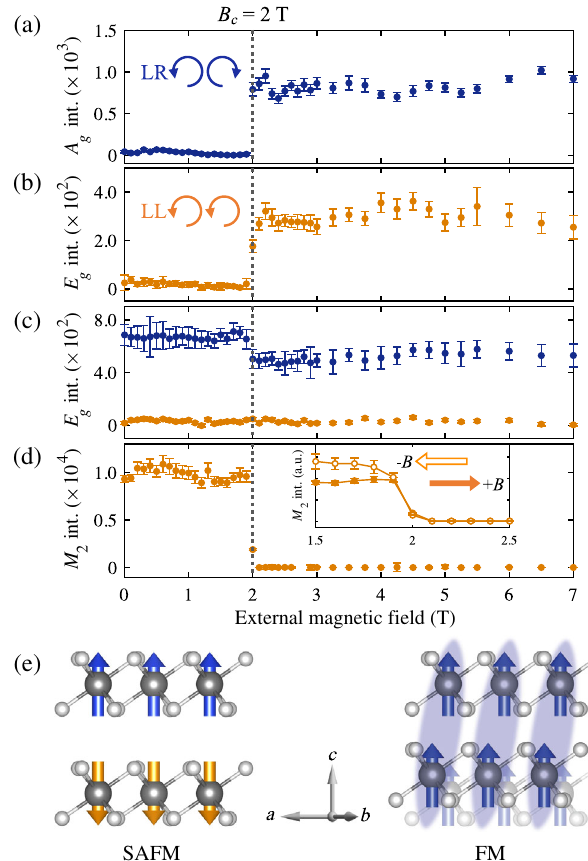
FIG. 3. Revealing the rhombohedral-to-monoclinic structural phase transition at B in 3D CrI 3 . Magnetic field dependence of c phonon (at approximately 129 cm − 1 ) (a) a representative A g intensity leakage into the LR channel, (b) an example of an E g phonon (at approximately 109 cm − 1 ) intensity showing up in the LL channel, which corresponds to the E phonon of the C 3 g i ð C Þ ] transforming into the A structure [i.e., E phonon of the 3 i g g ð C Þ ], (c) an example of the E C 2 structure [i.e., A phonon (at 2 h h g g approximately 240 cm − 1 ) intensity experiencing a clear discon- tinuity in the LR channel but remaining absent in the LL channel ð C Þ phonon transforming into a B ð C Þ corresponding to an E 3 i 2 h g g mode, and (d) M 2 -mode intensity. Inset shows an enlargement between 1.5 and 2.5 T with both increasing ( þ B ) and decreasing ( − B ) magnetic fields. Error bars correspond to one standard error of the fitted peak intensities. (e) Schematic illustration of the shearing of CrI 3 layers across the magnetic phase transition B . The light blue ellipses represent the directors between layers c formed because of this lattice